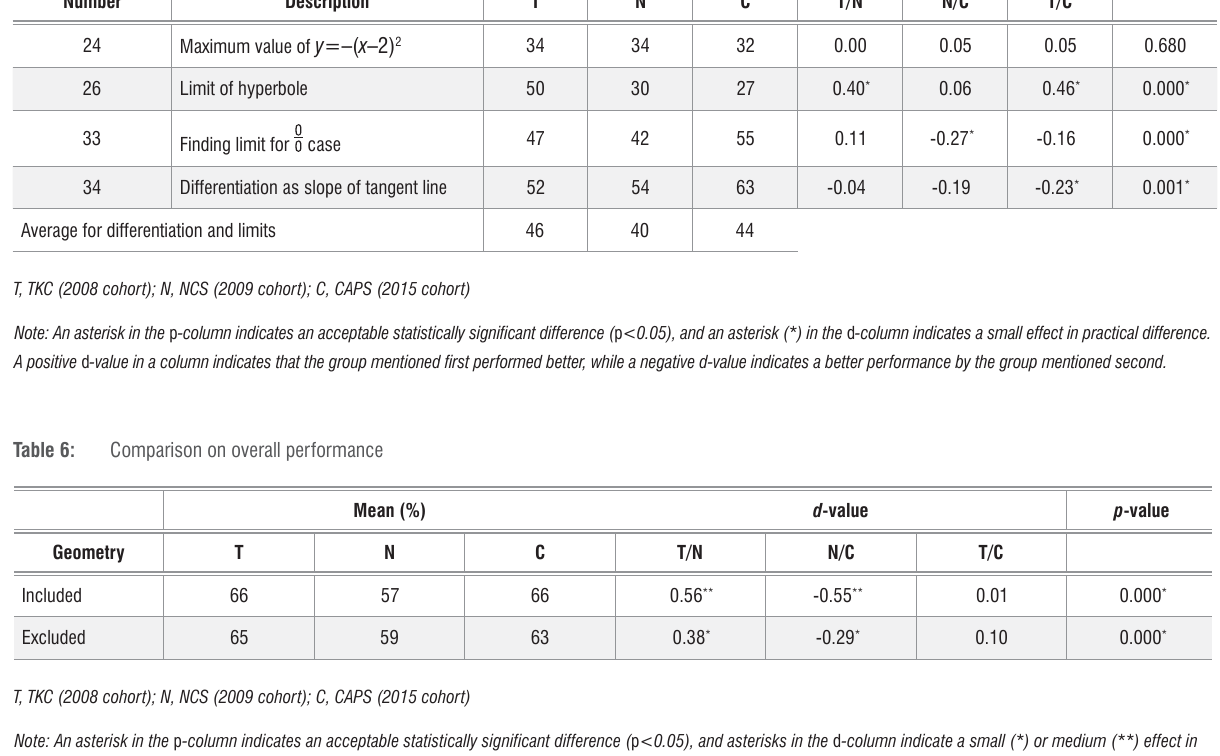
Question by question comparison for differentiation Question